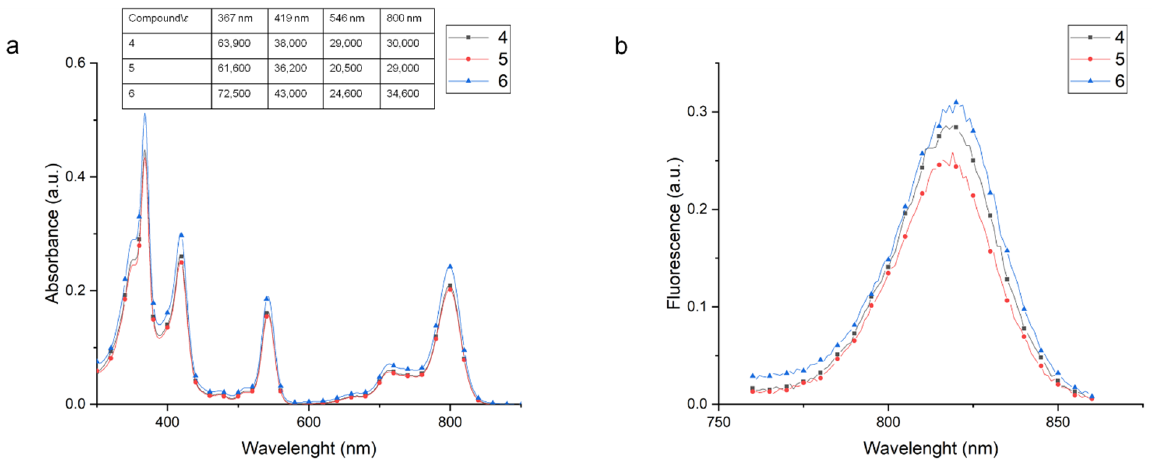
Figure 1. Electronic absorption ( a ) and fluorescence ( b ) spectra of the compounds obtained.